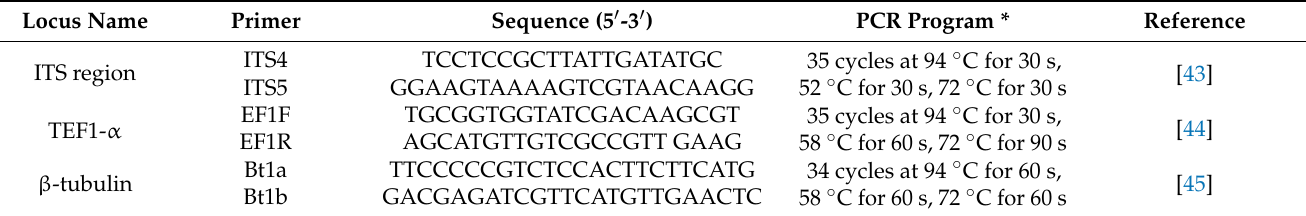
Table 3. Nucleotide sequence of the primers used in the study.